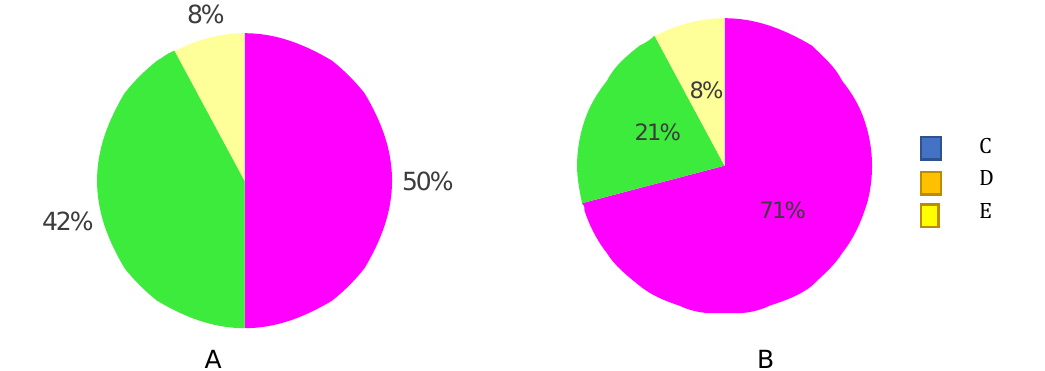
Fig.1. Change of children’s distribution by homogeneity of the analyzed characteristics (by cluster analysis). A – at the beginning of academic year; B – at the end of academic year; C – average values and above average; D – average values and below average; E – values below